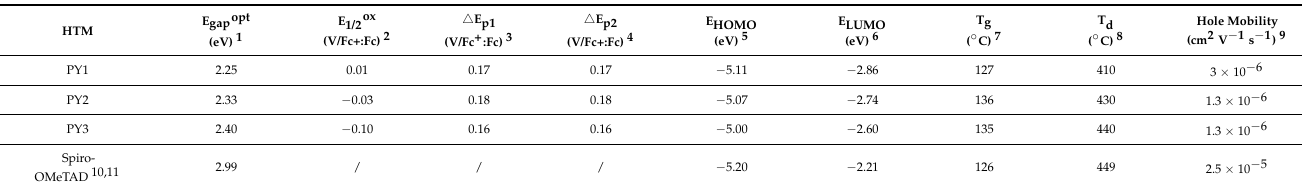
Table 1. Optical, electrochemical, thermal and mobility properties of the compounds.